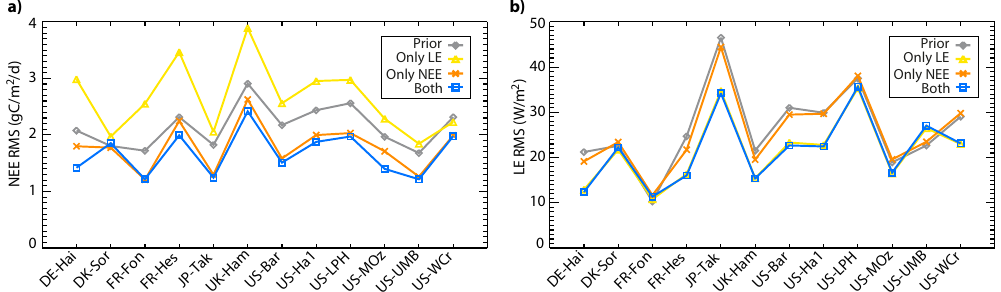
Fig. 7. Daily model-data RMSs at the sites for (a) NEE and (b) LE. Prior model is in grey, and compared with three MS optimizations using different sets of data: LE only (yellow), NEE only (orange), and LE+NEE